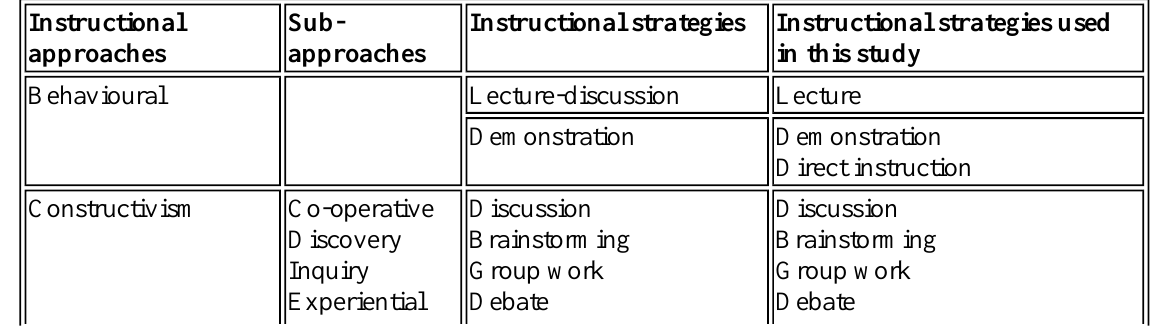
Table 1 Learning theories, instructional approaches and strategies in the context of this study